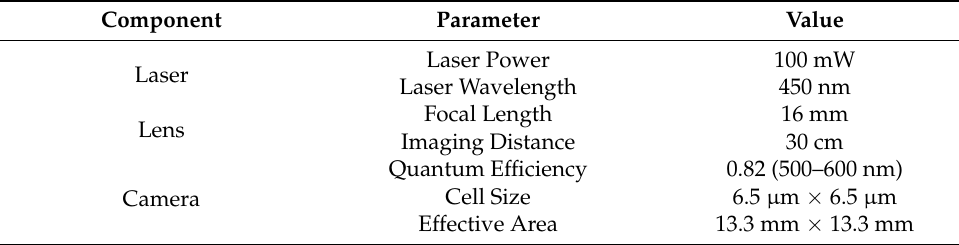
Table 1. The main parameters of the